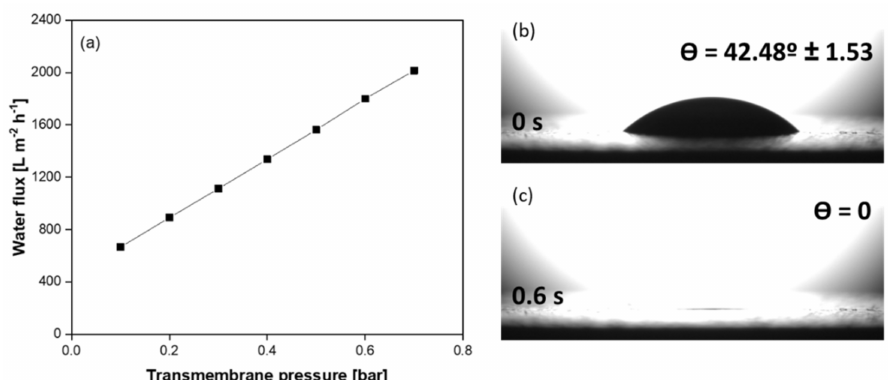
Figure 11. ( a ) Pure water flux as a function of applied transmembrane pressure for duplicated SiC membranes in a crossflow configuration and ( b , c ) The water/membrane initial contact angle image of SiC membrane and the contact angle image of SiC membrane when the water droplet reached to a steady position,